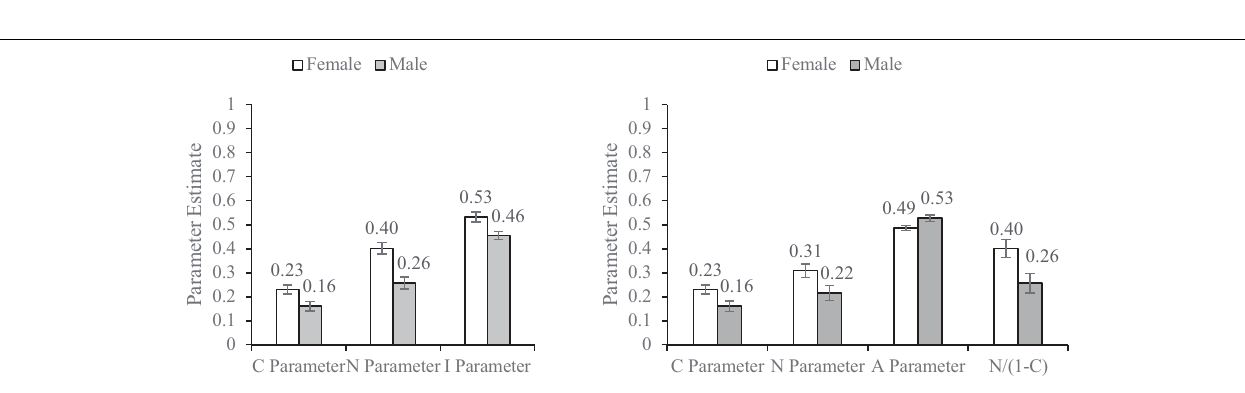
Frontiers in Psychology |